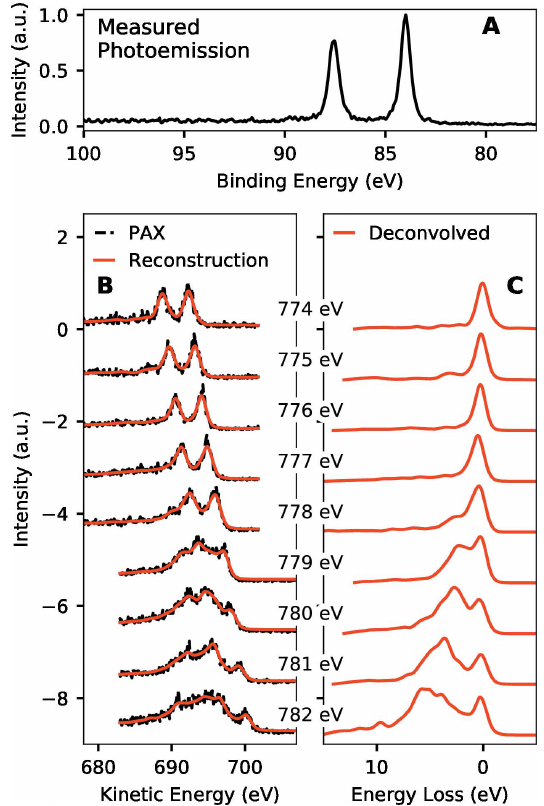
Figure 8 Results of the algorithm described in this report on the (cid:2) 0.5 eV resolution experimental data from Dakovski et al. (2017). These data use PAX with the Au 4 f levels as a photoemission converter to look at RIXS from a CoO sample near the Co L 3 -edge. (A) Experimentally measured Au 4 f photoemission spectrum. (B) Raw PAX data (black) as well as the reconstruction of that data from the deconvolved results (red) as a function of incident X-ray photon energy. (C) RIXS spectra that result from deconvolving the PAX spectra shown in (B).